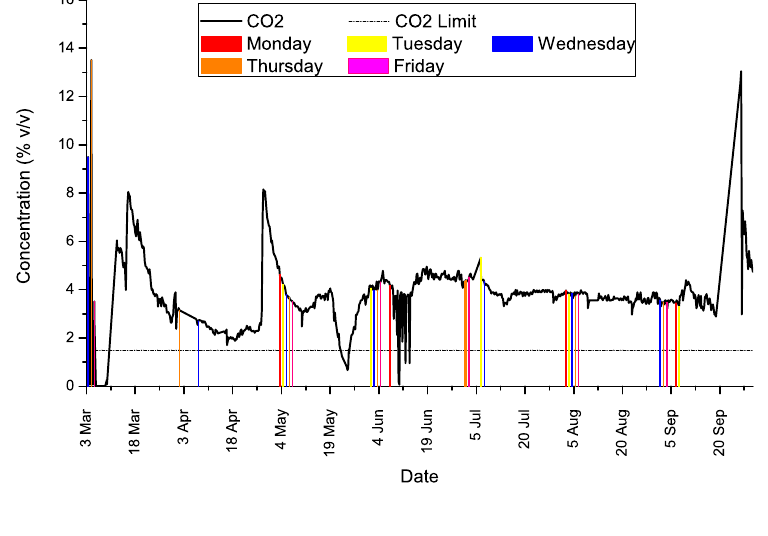
Figure 11. CO 2 readings over a 7 month field deployment at location C between March